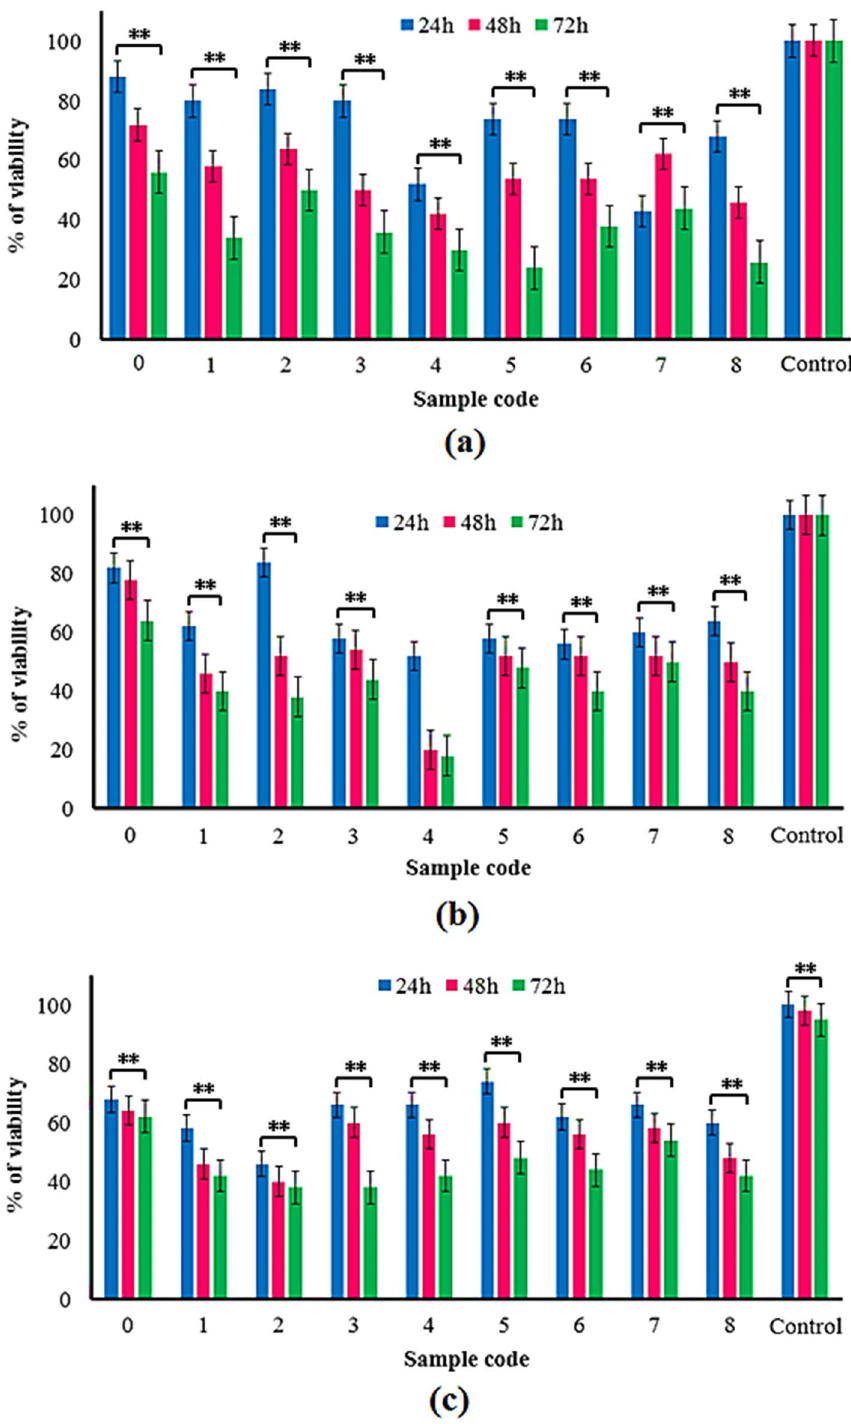
Figure 11. Bar diagram shows results for mortality rate (a = 24, b = 48, and c = 72 h) of brine shrimp A. Salina treated with solutions obtained from released SNPs from coated fabrics at 24, 48, and 72 h in comparison with uncoated fabric as blank, ** P < 0.05. Sample 0 (Uncoated fabric), Samples 1–4 and 5–8 (NS-coated fabrics at 2, 10, 20, and 50 mM silver nitrate concentrations, and 25 and 50 min sonication time,